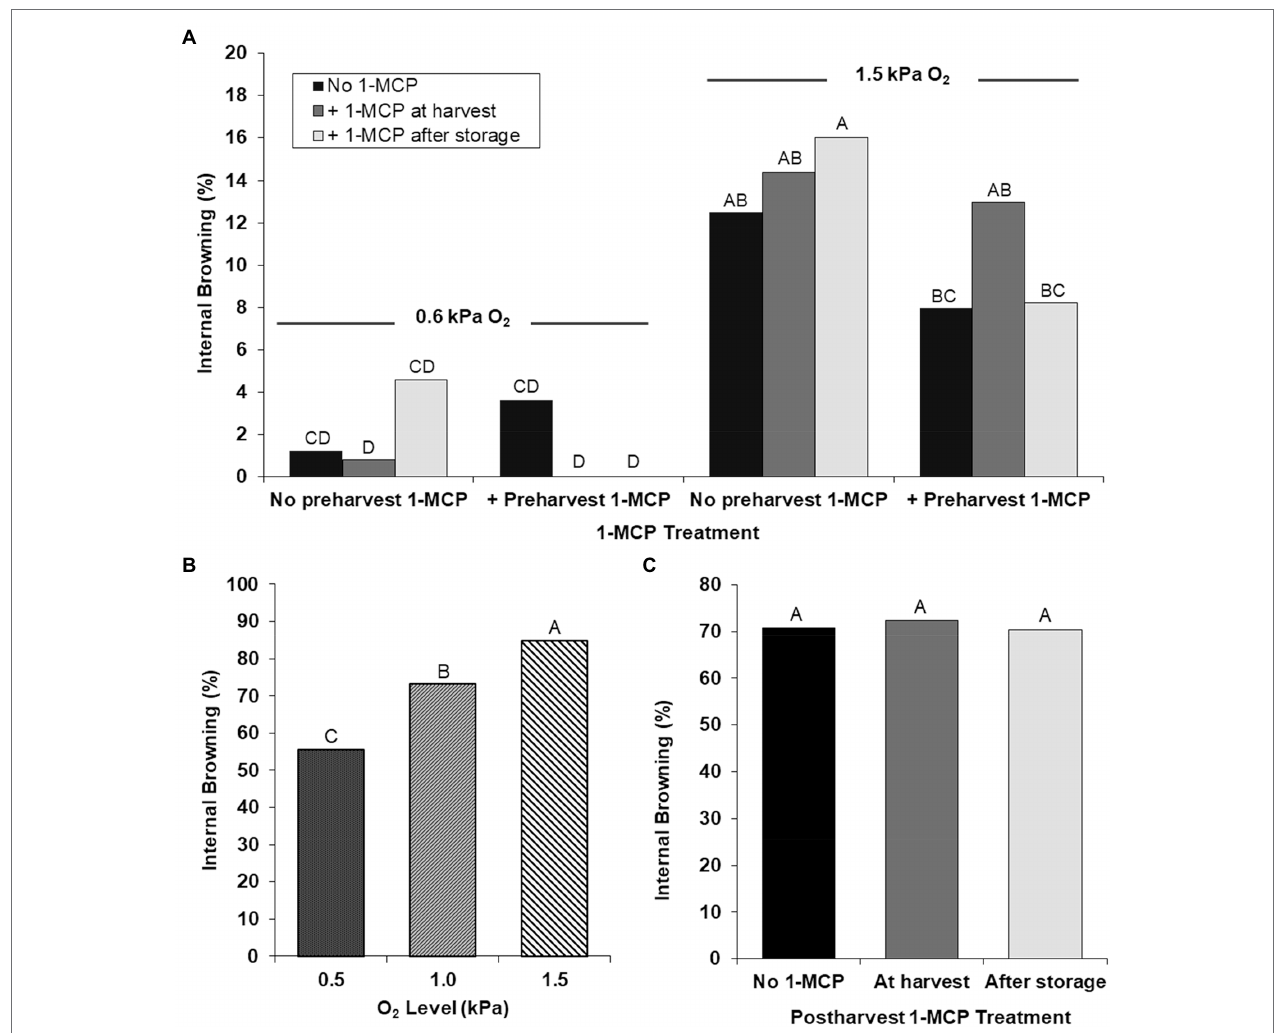
FIGURE 2 | Internal browning of ‘Gala’ apples: (A) treated without or with preharvest 1-MCP at 7 days before harvest in combination without or with postharvest 1-MCP (1 μ l L − 1 ) for 24 h at harvest or after storage with 1.5 or 0.6 kPa O 2 + <0.5 kPa CO 2 at 0.5 ° C for 9 months plus 14 days at room temperature (RT, 21–22 ° C) in Year 1; (B) overall effect of low O 2 when stored in 1.5, 1.0, or 0.5 kPa O 2 + <0.5 kPa CO 2 for at 0.5 ° C for 8 months plus 14 days at RT in Year 2; and (C) overall effect of postharvest 1-MCP when treated without or with postharvest 1-MCP (1 μ l L -1 ) for 24 h at harvest or after storage with 1.5, 1.0, or 0.5 kPa O 2 + <0.5 kPa CO 2 at 0.5 ° C for 8 months plus 14 days at RT in Year 2. Values within a graph with the same letter are not significantly different at p < 0.05.